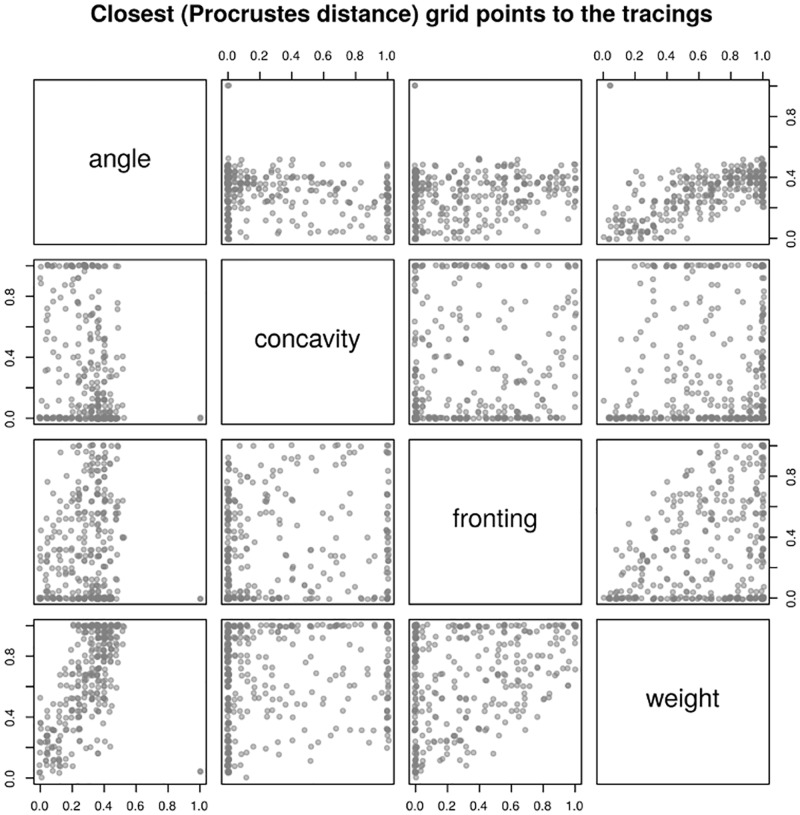
Closest (in terms of Procrustes distance) grid point to the tracings.Each dot represents the closest (in terms of minimizing the Procrustes distance) grid point to a tracing (the actual values have been jittered for better visualization). Each panel represents a 2D projection on two parameters of the 4-dimensional parameter space.